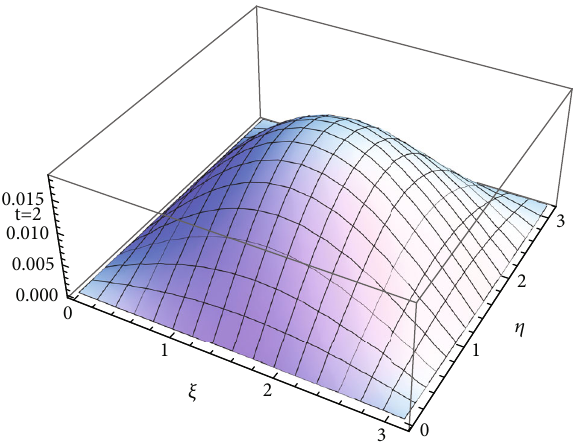
Figure 14: Approximate solution for Example 9 at t=2.